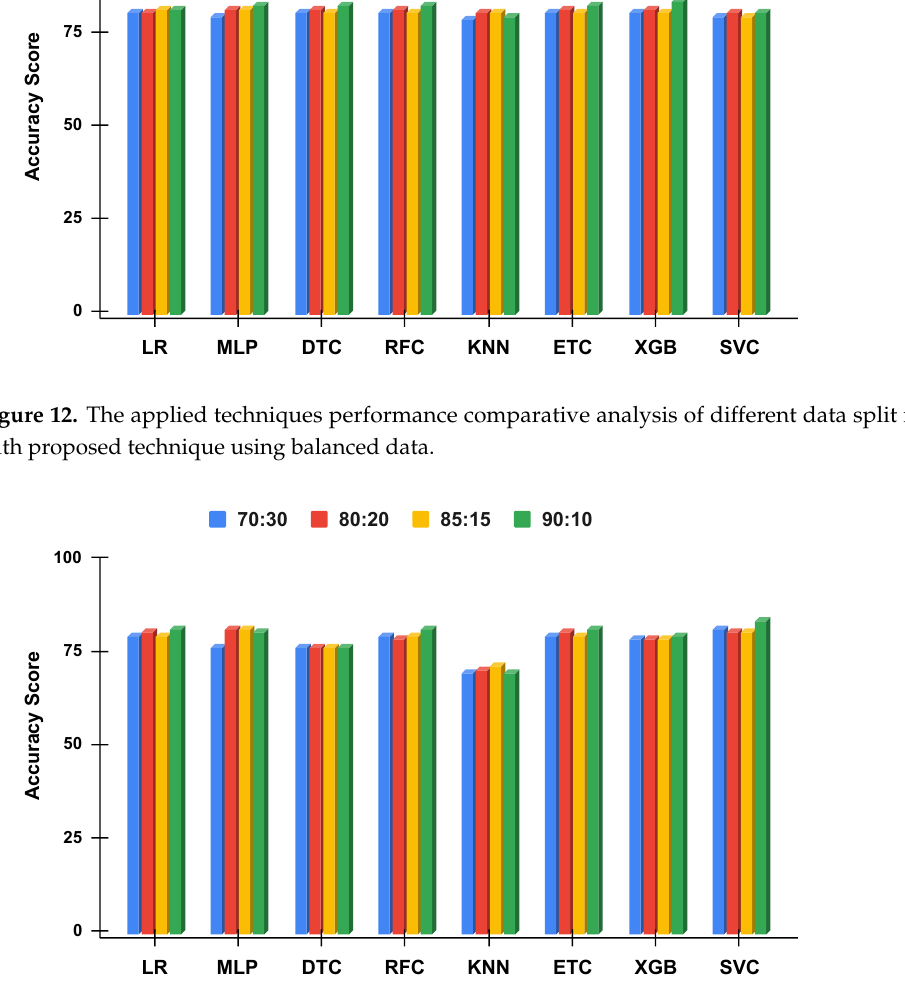
Figure 13. The applied techniques performance comparative analysis of different data split ratios without proposed technique using balanced